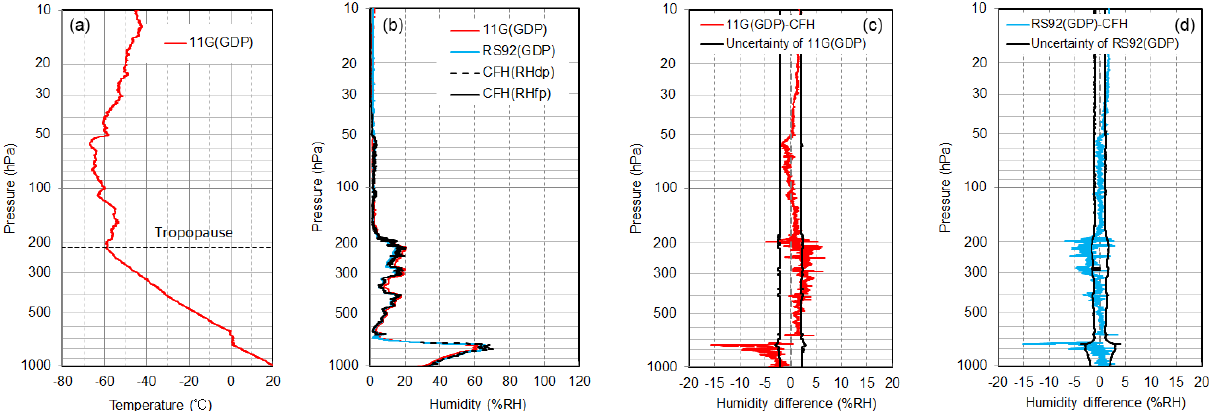
Figure 29. Profiles of temperature and RH / RH difference from an RS-11G, RS92, and CFH comparison flight launched at 14:50 (LST) on 20 April 2018. Panel (a) shows temperature data from RS-11G GDP. Panel (b) shows RH of RS-11G GDP (red), RS92 (light blue), converted RH from CFH dew point temperature (dashed black line) below the height of the forced freezing point, and converted RH from CFH frost point temperature (thick black line) above the height of the forced freezing point. Panel (c) shows RH differences for RS-11G GDP (red) from CFH and the overall uncertainties of RS-11G GDP (black). Panel (d) shows RH differences for RS92 GDP (light blue) from CFH and the overall uncertainties of RS92 GDP